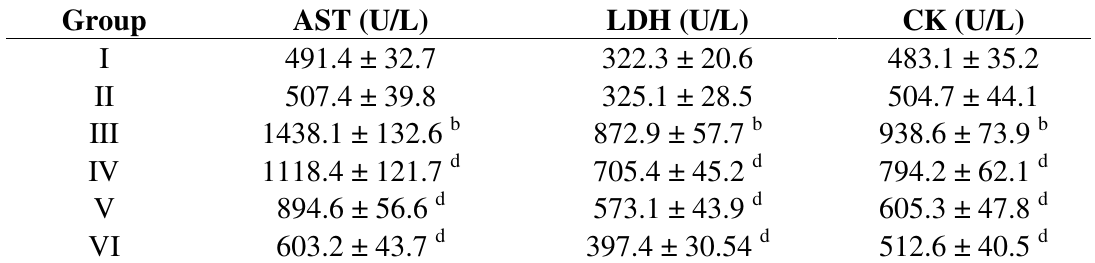
Table 3. Effect of GBE50 on blood AST, LDH, and CK activities in rats.